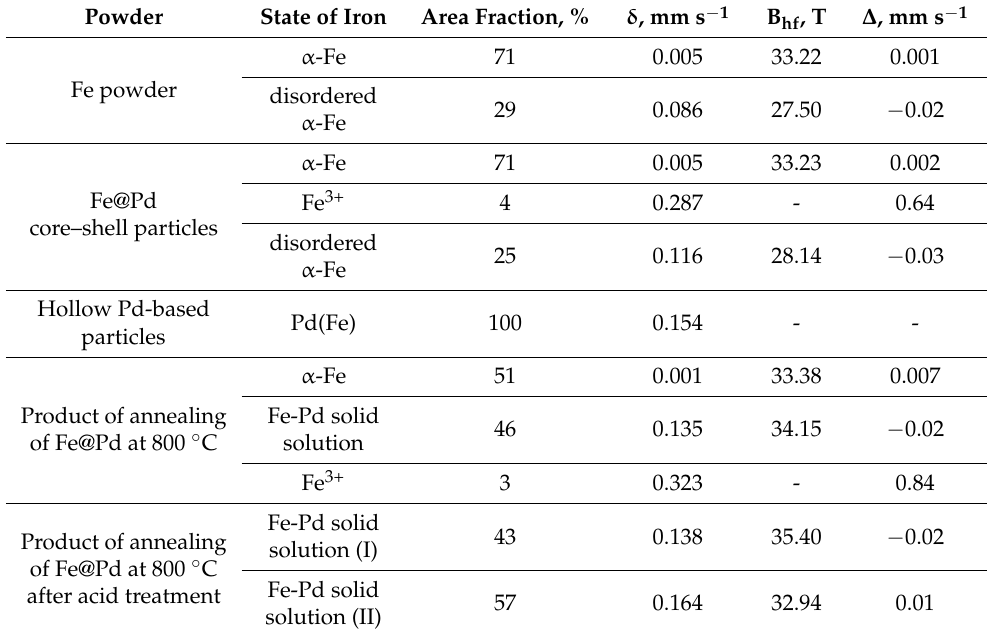
Table 2. Parameters of the Mössbauer spectra of the Fe-Pd powder alloys